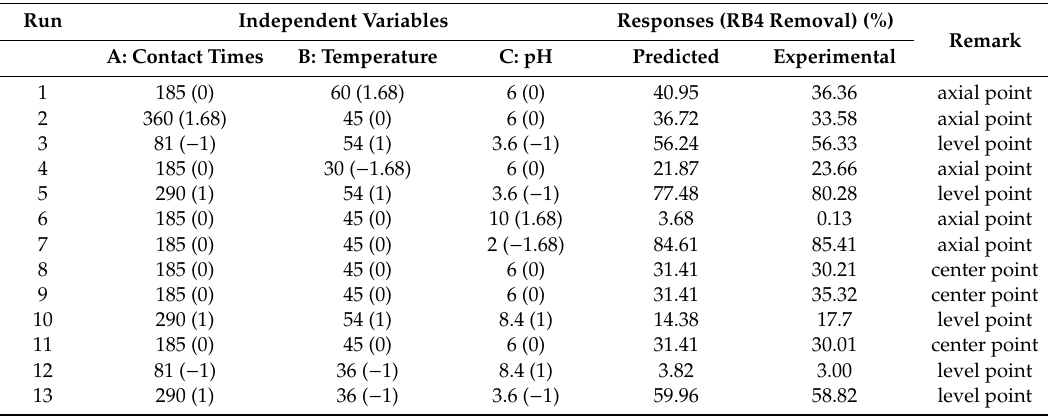
Table 1. Central composite design matrix and reactive blue 4 (RB4) dye